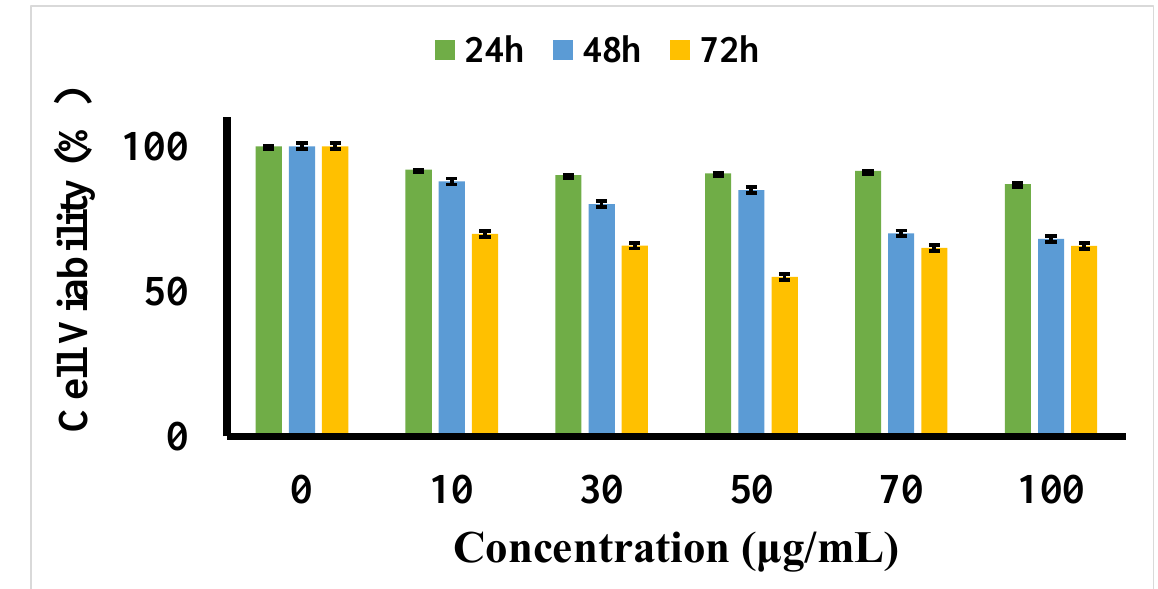
Figure 3. Cell viability MTT assay for varying concentrations of D-SPIONs on BCECs over 24, 48, and 72 h. Data are presented as means ± standard deviations (n = 3). One-way analysis of variance and the Tukey post hoc test revealed no significant difference based on the different incubation times ( p > 0.05).